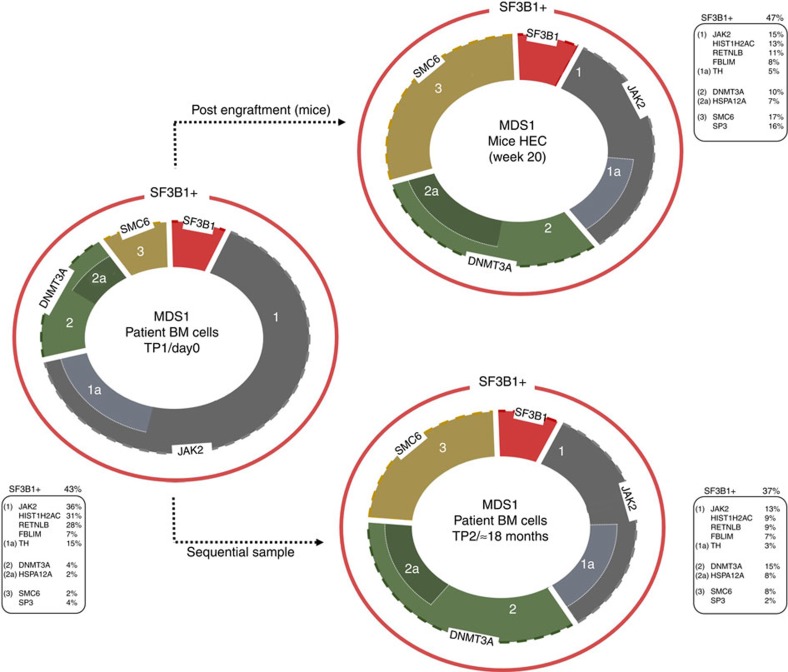
Xenograft recapitulates the clonal changes occurring in RARS patient bone marrow compartment.Mutational analysis of sequential primary TNC (total nucleated cells) sample from one patient (MDS1). Primary patient sample was received at two different time points, MDS1 bone marrow cells (TP1, first sample) and MDS1 bone marrow cells (TP2, second sample). Mutational analysis was also performed on human engrafted cells, which were obtained from mice transplanted with the patient sample received at time point 1. The length of the arc represents the MABs. Gene MAB for human engrafted cells is the average between three animal experiments. Three independent PCR/sequencing experiments were performed to confirm/determine the mutant allele burden throughout the experiments. Error Bar in the bar chart were derived from the PCR/sequencing technical replicates. MAB, mutant allele burden; TP, time point; HEC, human engrafted cells; BM, bone marrow cells.